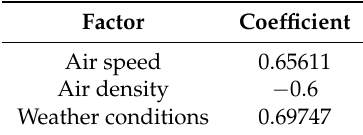
Table 1. Simulation results for regression parameters estimation (Step 3).